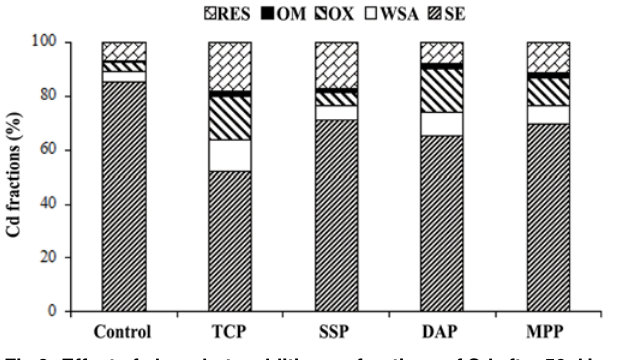
Fig 2. Effect of phosphate addition on fractions of Cd after 50 d